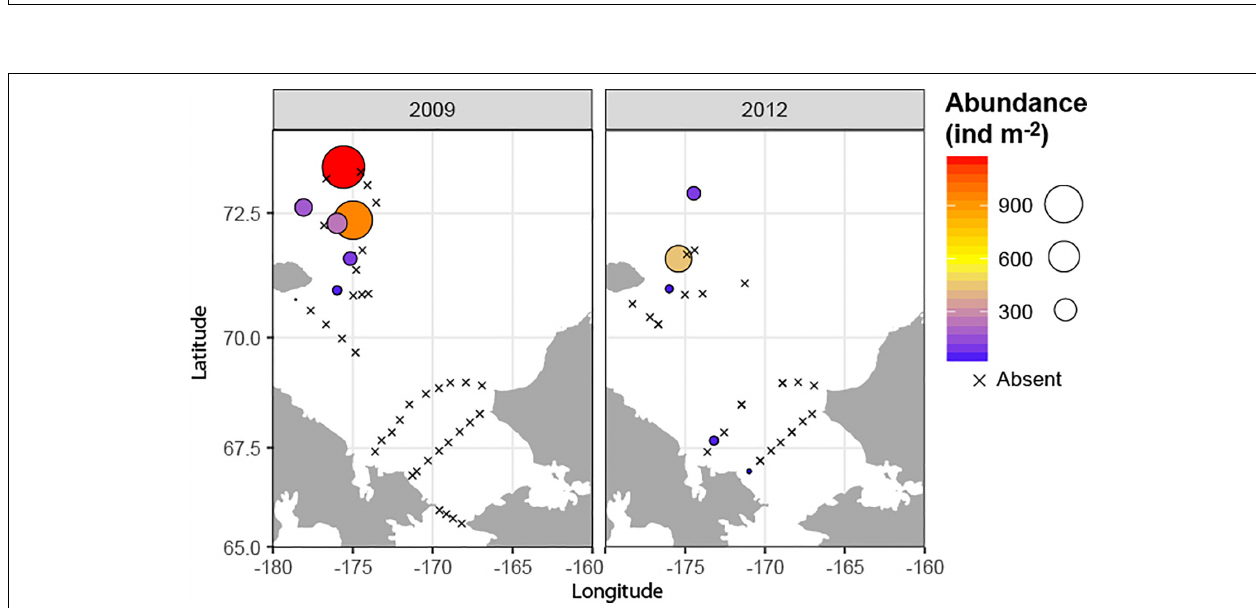
FIGURE 9 | Distribution of Ceriantharia actinulae (not observed during all other study years).